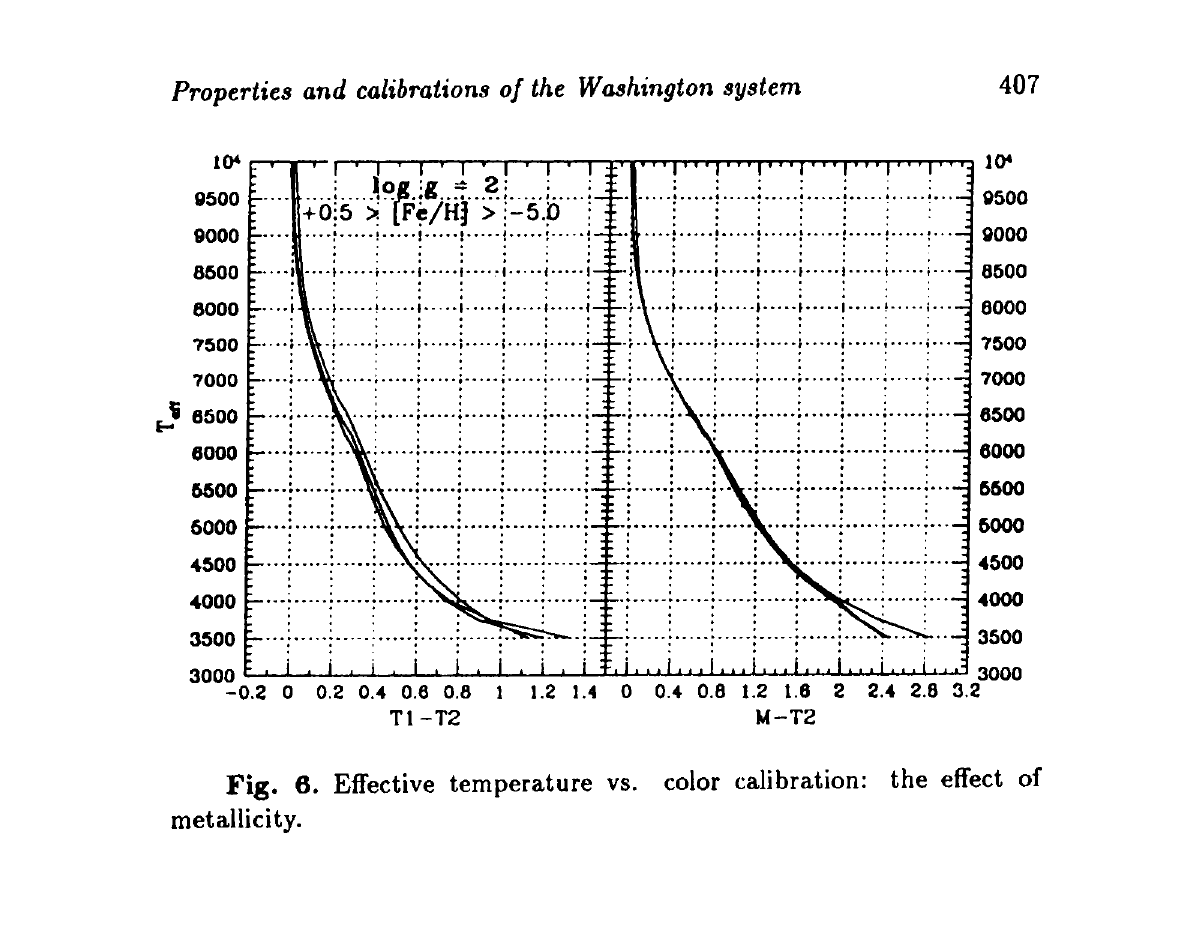
Fig. β. Effective temperature vs. color calibration: the effect of